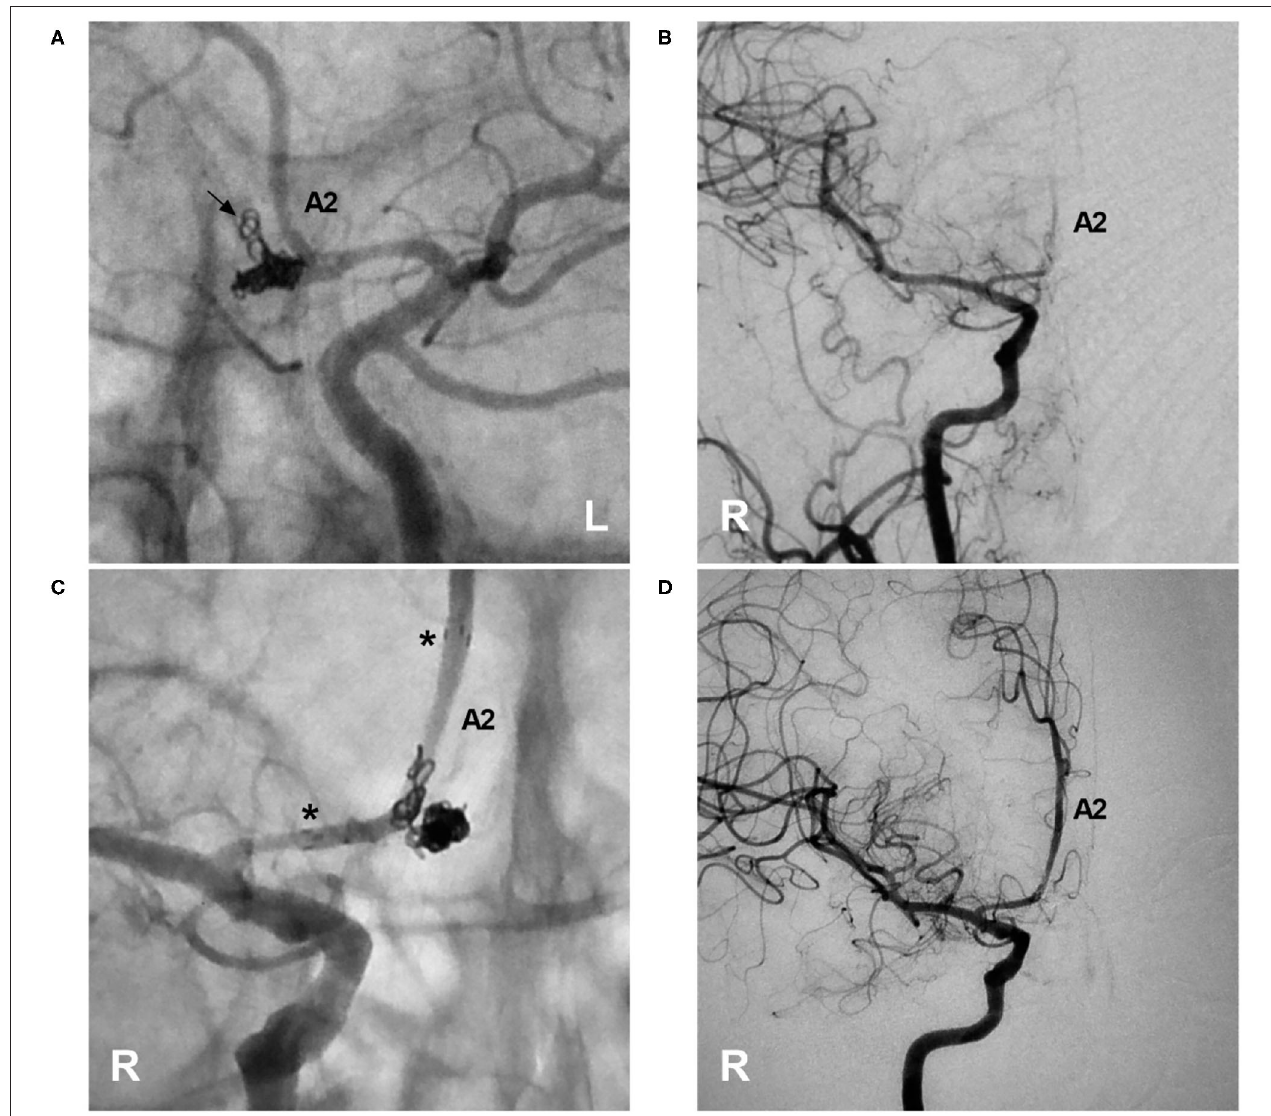
FIGURE 10 | Rescue stenting with the NAS to address coil protrusion. (A) Unsubtracted DSA of the left ICA showing the complete coiling of an AcomA aneurysm; coil protrusion (arrow) into the contralateral artery through the AcomA was suspected. (B) DSA of the right ICA confirming coil protrusion and showing occlusion of the right A2 segment. (C) Unsubtracted DSA of the right ICA showing deployment of the NAS across the coil protrusion; the asterisks indicate the proximal and distal tips of the NAS. (D) DSA of the right ICA showing recanalization of the right A2 segment and restoration of normal blood flow. A2, second segment of the anterior cerebral artery; AcomA, anterior communicating artery; DSA, digital subtraction angiography; ICA, internal carotid artery; NAS, Neuroform Atlas stent; L, left; R,